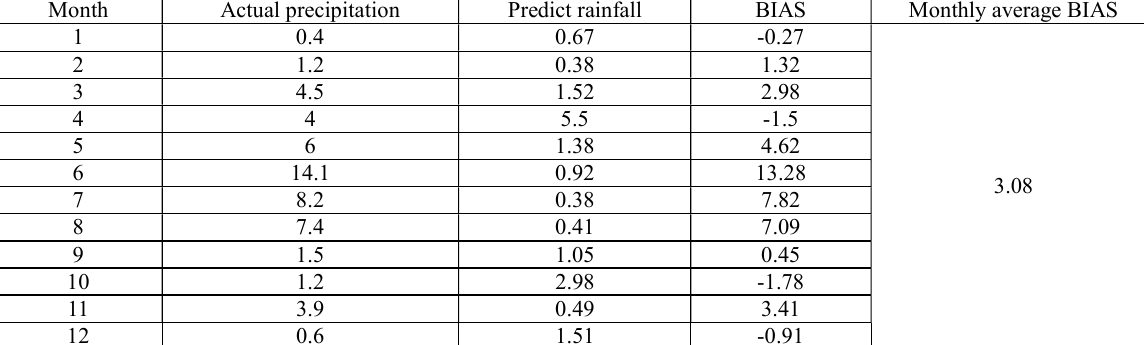
Table 3. Monthly daily average precipitation and forecast precipitation in 2017